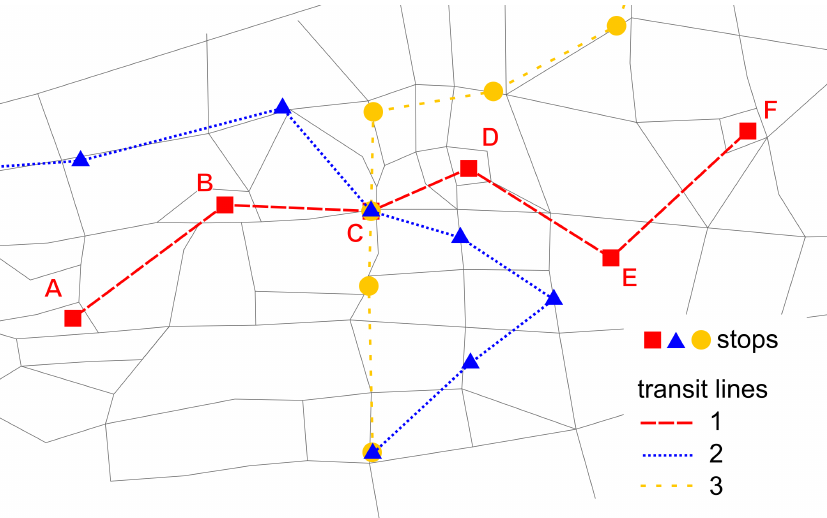
Figure 1. An example network containing three public transit lines: line 1 (dashed red), line 2 (dotted blue) and line 3 (dashed yellow). Line 1 is used to illustrate the mapping algorithm in Section 2.2. All transit lines have two transit routes, one going from the first to the last stop and one transit route back. Stop C is used by all three transit